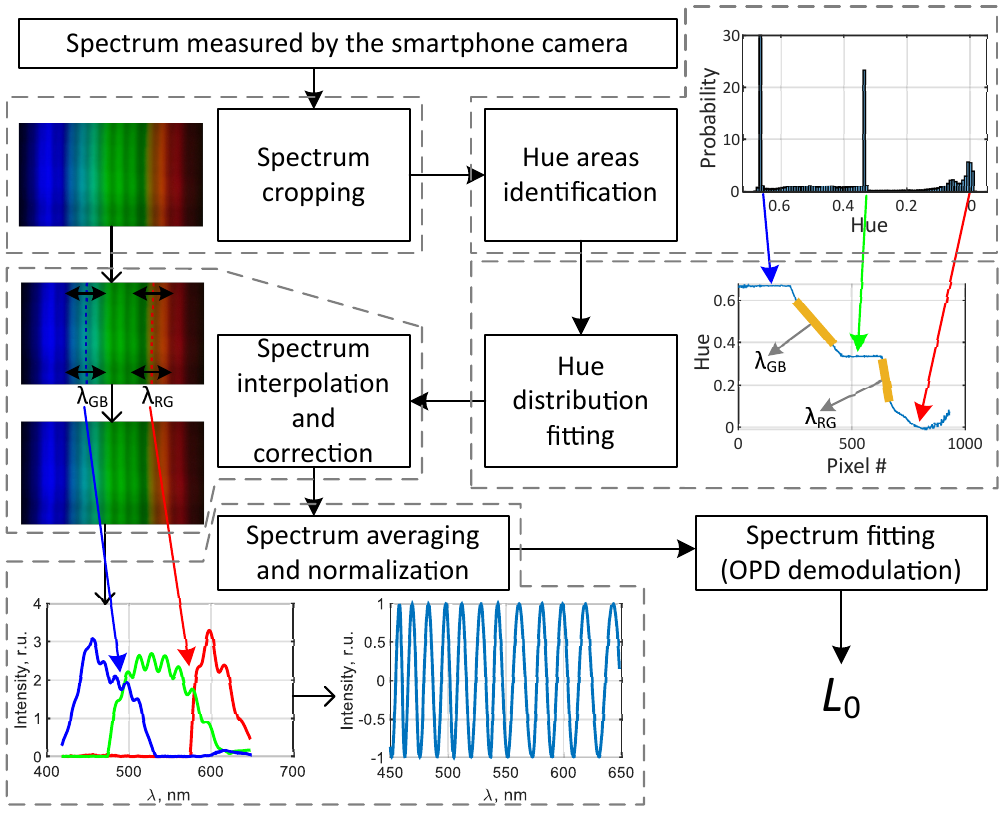
Figure 5. Schematic representation of signal processing workflow. Dashed gray lines indicate separate processing stages and what changes are made to the